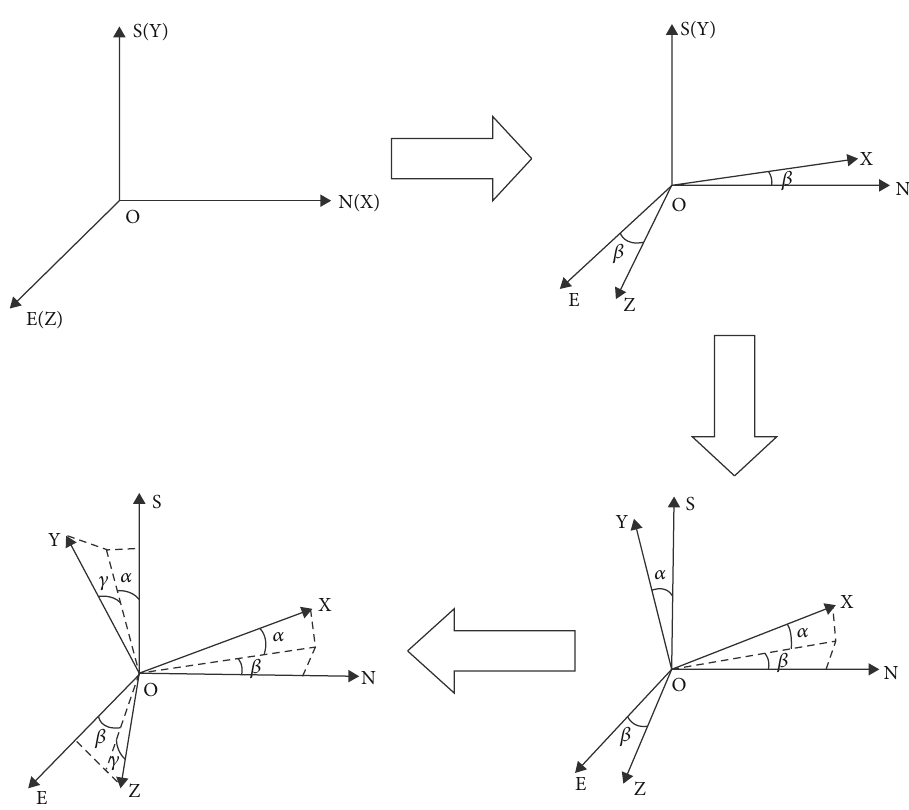
Figure 2: Coordinate system transformation